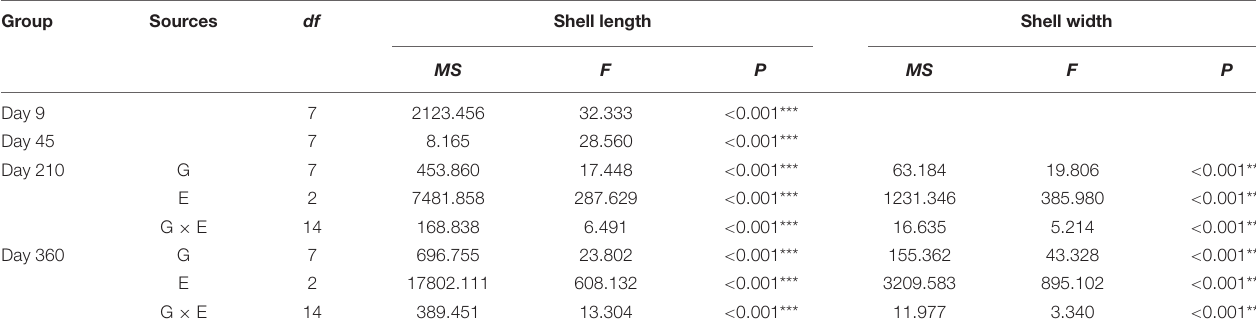
FIGURE 3 | The shell length and shell width of each group of P. martensii at different ages and sites. The different letters at each age indicate significant differences among groups ( P < 0.05). (A) Shell length on Day 9, on the horizontal, 1 for SBA, 2 for CBA, 3 for SAB, 4 for CAB, 5 for SAA, 6 for CAA, 7 for SBB, 8 for CBB; (B) shell length on Day 45, on the horizontal, 1 for SBA, 2 for CBA, 3 for SAB, 4 for CAB, 5 for SAA, 6 for CAA, 7 for SBB, 8 for CBB; (C) shell length on Day 210 and 360, on the horizontal, 1 for Day 210 at Zhulin site, 2 for Day 210 at Huolu site, 3 for Day 210 at Qingshantou site, 4 for Day 360 at Zhulin site, 5 for Day 360 at Huolu site, 6 for Day 360 at Qingshantou site; (D) shell width on Day 210 and 360, on the horizontal, 1 for Day 210 at Zhulin site, 2 for Day 210 at Huolu site, 3 for Day 210 at Qingshantou site, 4 for Day 360 at Zhulin site, 5 for Day 360 at Huolu site, 6 for Day 360 at Qingshantou site. TABLE 3 | One-way analysis of variance showing the differences in growth parameters among different groups (Days 9 and 45) of P. martensii .